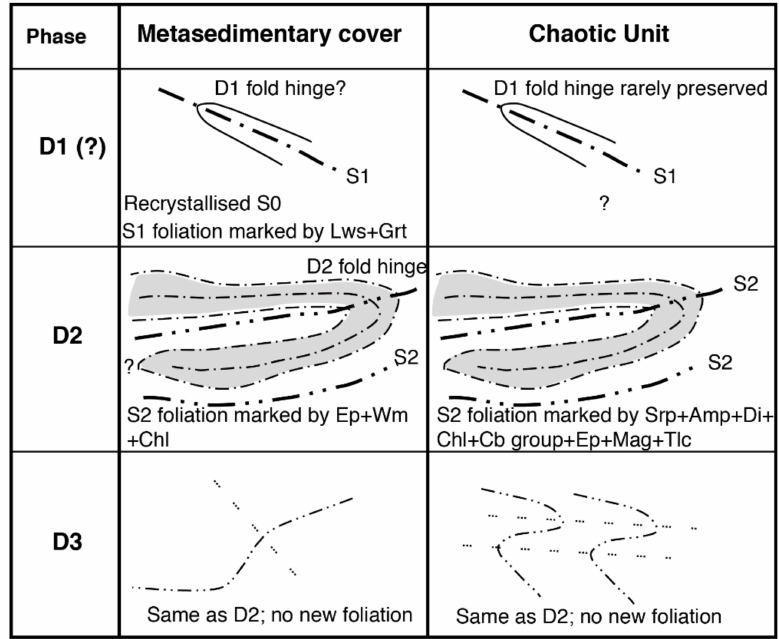
Figure 8. Schematic representation of outcrop scale structures developed in the high Champorcher valley CCU and metasedimentary